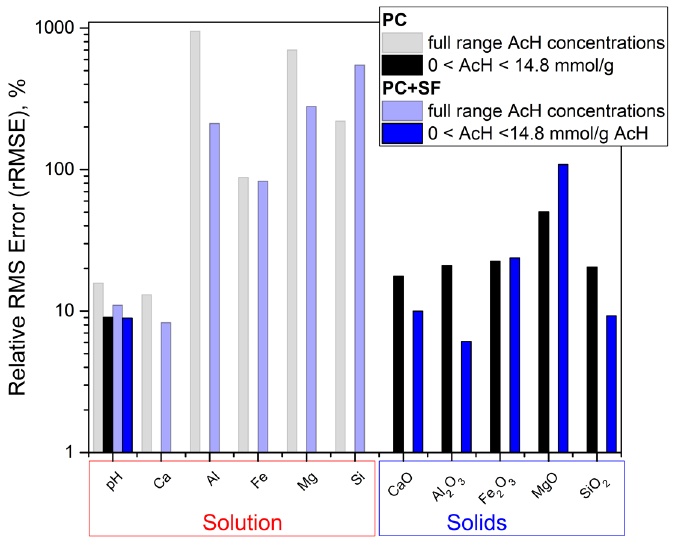
Figure 10. Deviations between model and experiment, calculated as relative root square mean error (rRSME) for pH, dissolved ions in acid solution and oxide composition in remaining solids, both for a full range of acid concentrations that range up to 14.8 mmol/g ( hcp ) .